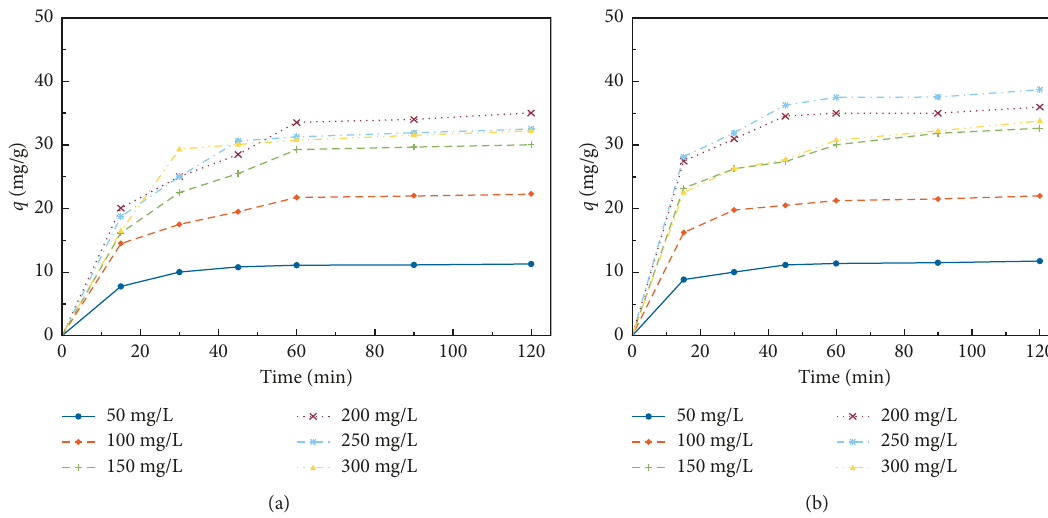
Figure 2: Effect of contact time on dye (dose 4g/L) adsorption on (a) raw sawdust and (b) chemically treated sawdust.